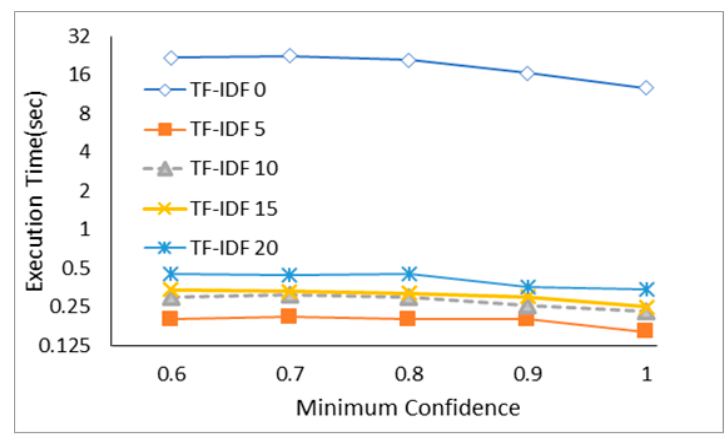
Figure 12. Word Count and Generation Speed according to TF-IDF and Confidence.